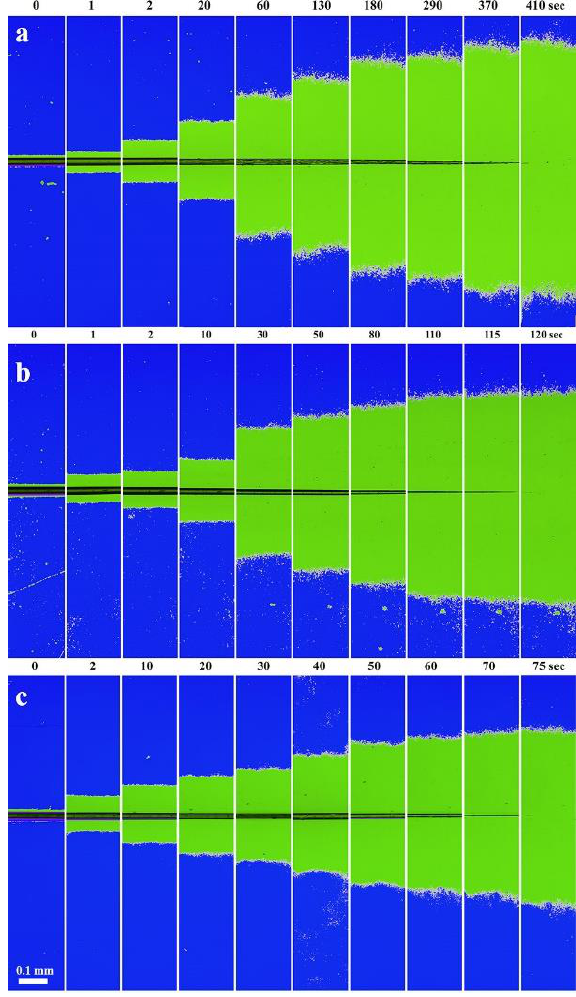
Figure A4. An example of images of the polymer solution boundary moving after image processing in the Lab color space in different solvents: ( a ) — 9:1, ( b ) — 7:3, ( c ) — 6:4.